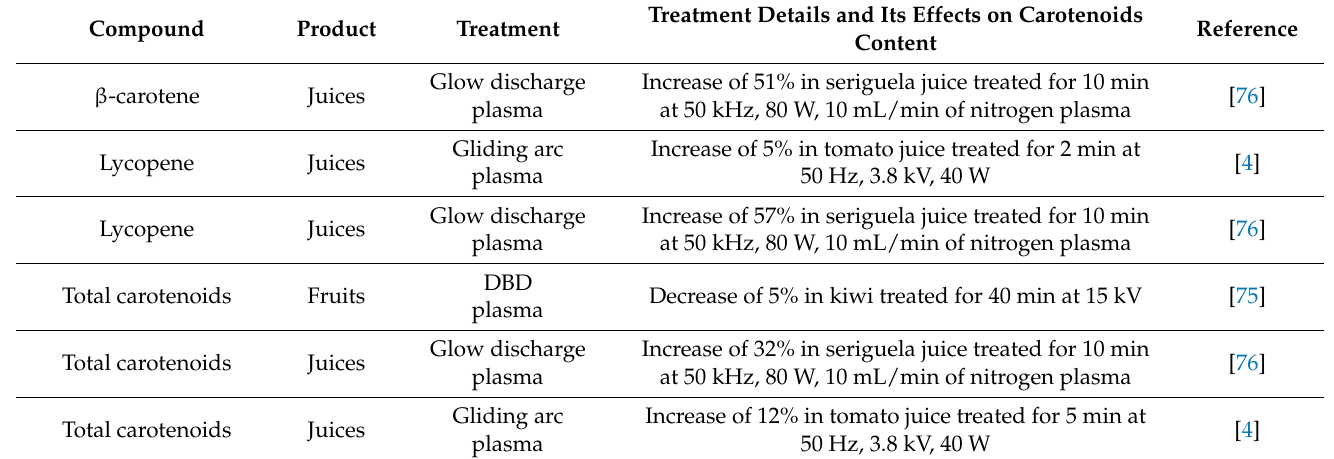
Table 6. Changes in carotenoids content induced by cold plasma application.